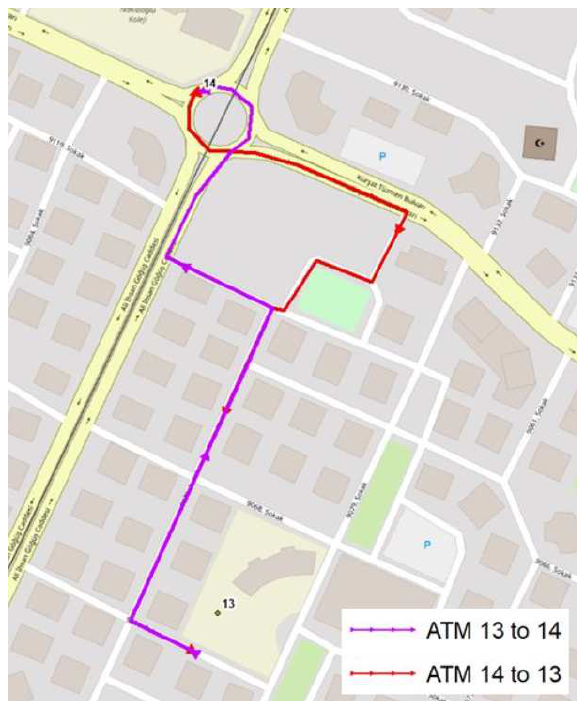
Figure 1. An example of asymmet- ric case from ATM 13 to 14, and from ATM 14 to